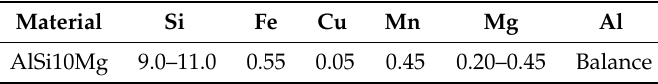
Table 2. Chemical composition of the AM powder in weight %.